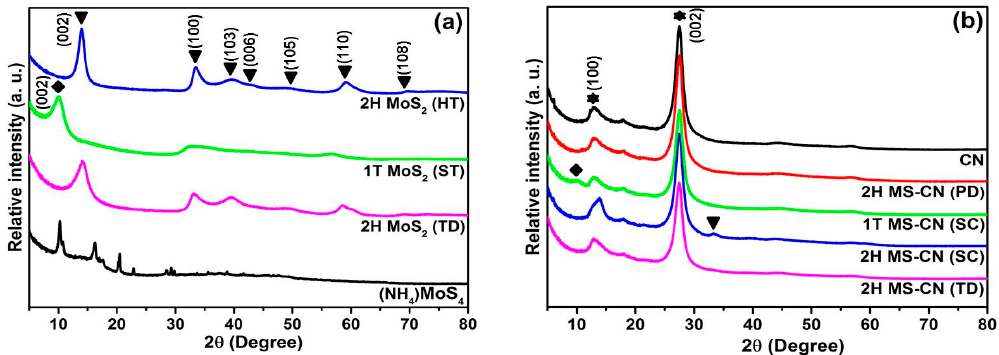
Figure 2. XRD powder patterns of ( a ) 1T MoS 2 (ST), 2H MoS 2 (SC), 2H MoS 2 (TD) and (NH 4 ) MoS 4 ; ( b ) pure CN and differently prepared MS-CN composites.